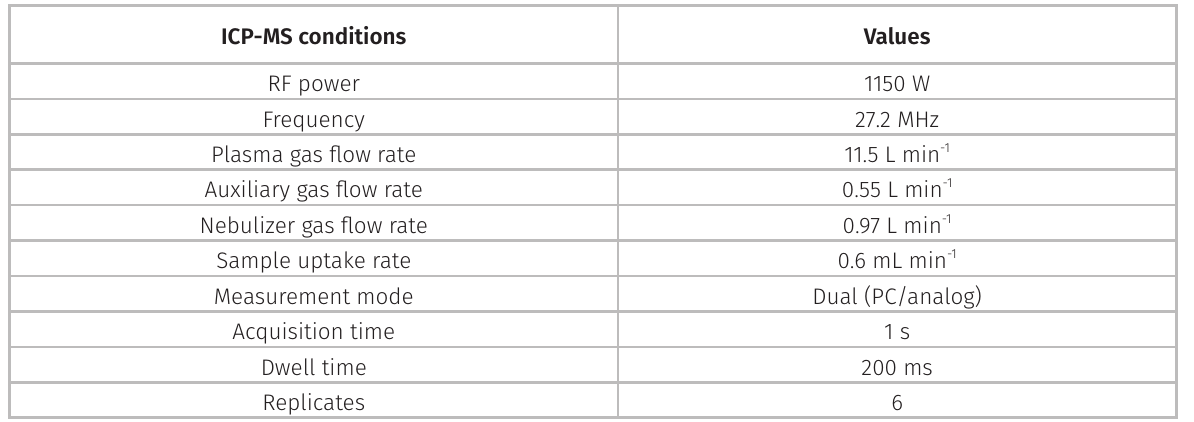
Table I. Instrumental conditions for ICP-MS